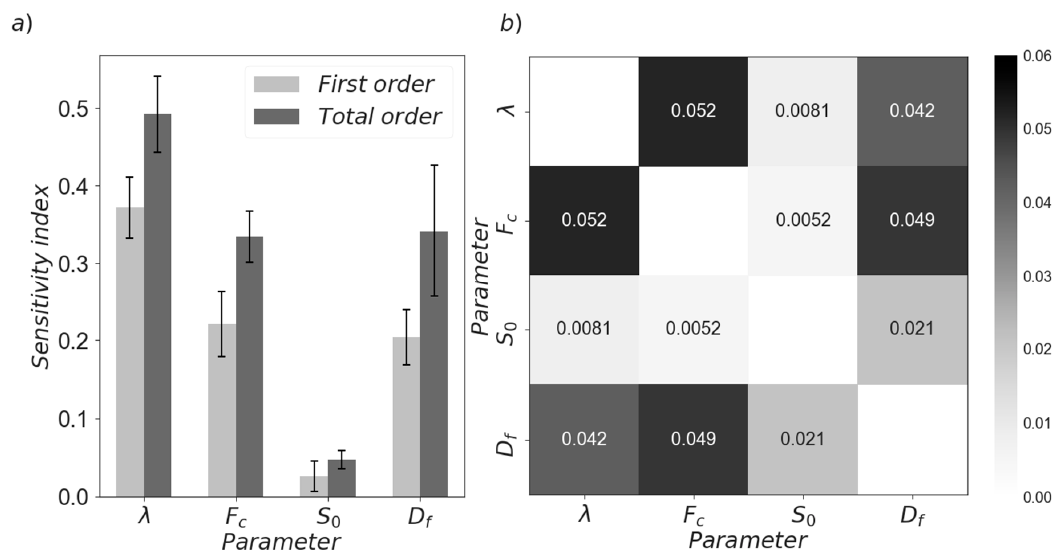
Figure 3. Sensitivity of the model to its parameters. ( a ) Total and first order effects. ( b ) Second order effects.